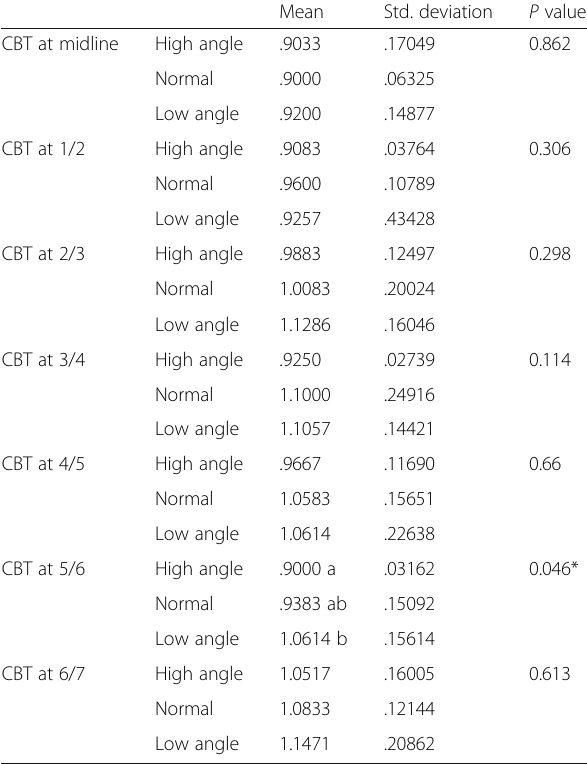
Table 2 Measurements of buccal inter-radicular cortical